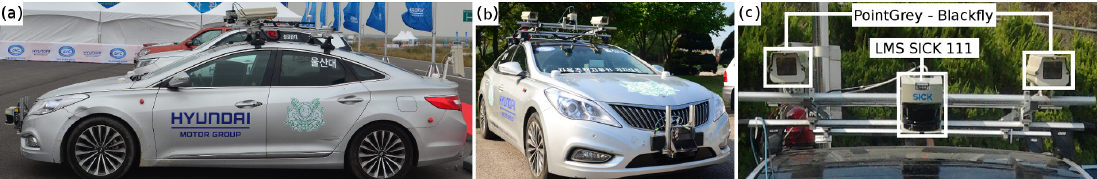
Figure 1. Vehicle data acquisition platform. ( a ) shows the lateral view of the vehicle; ( b ) shows the front view of the vehicle; and ( c ) shows the sensors located at the top of the vehicle at a height of approximately 1.8 m. The vehicle platform was equipped with Point Grey BlackFly cameras (Point Grey Research Inc., Richmond, BC, Canada) and a laser SICK Laser Measurement Sensor (SICK Ltd., Richmond Hill, ON,